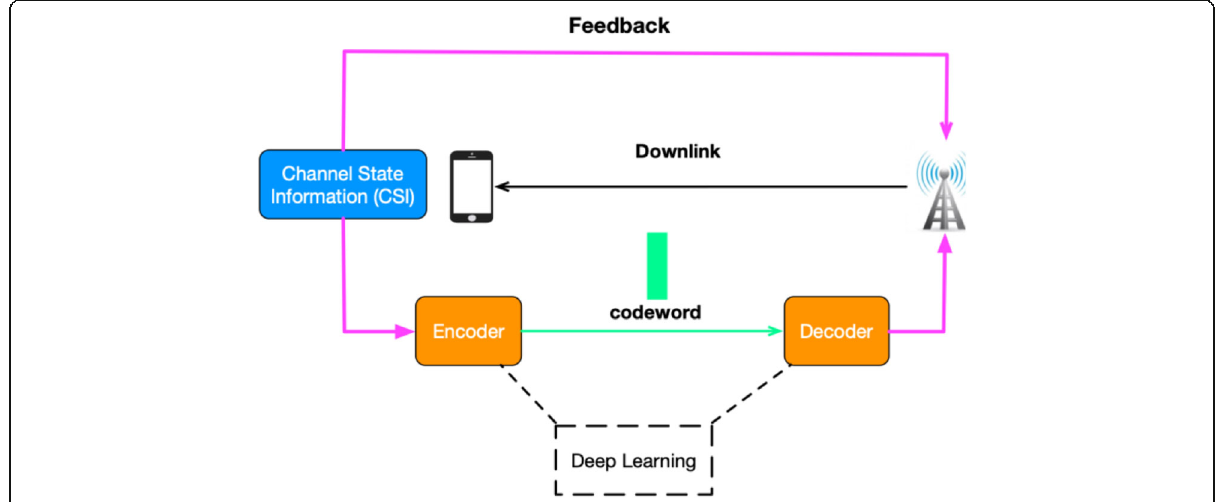
Fig. 2 Deep learning-based CSI feedback